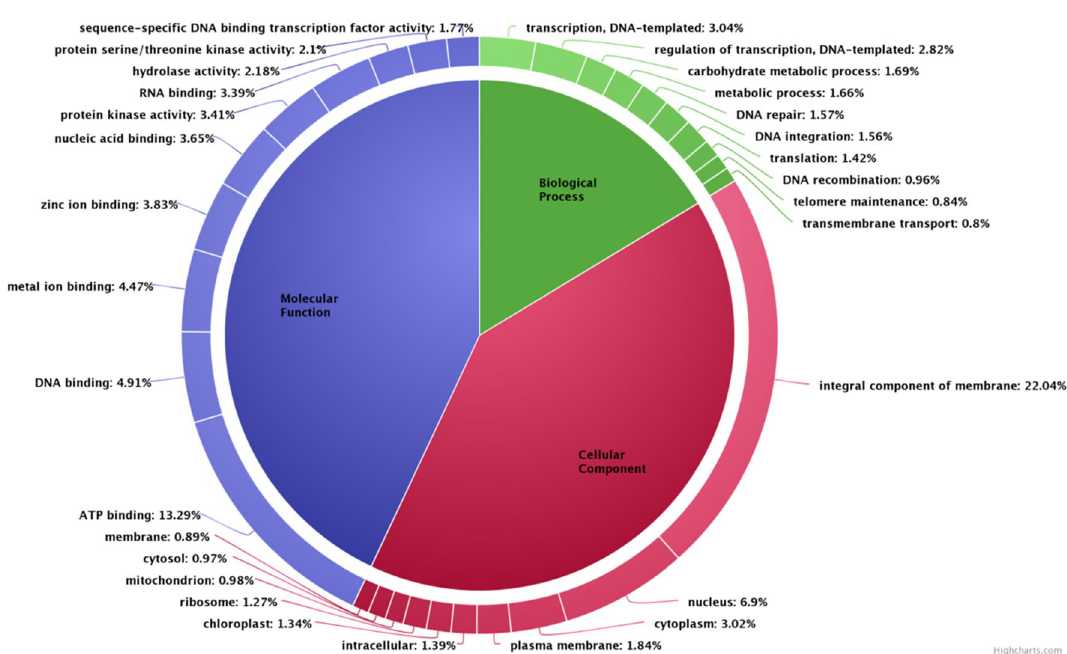
Figure 4. Frequency of top 10 abundant GO terms under biological process, molecular function and cellular component categories in Urochondra